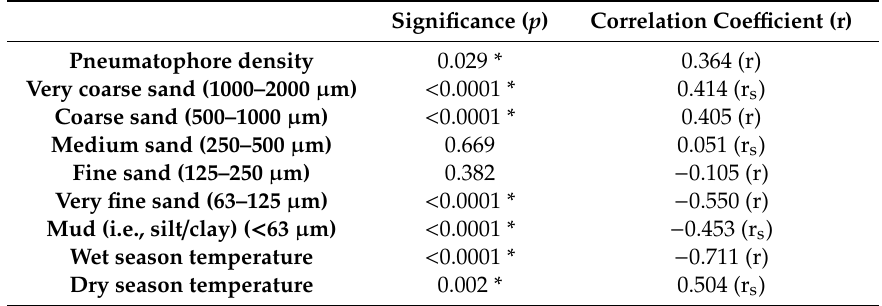
Summary of results of correlation analyses between microplastic abundance and pneumatophore density, mangrove sediment size and sediment temperature. Significance ( p